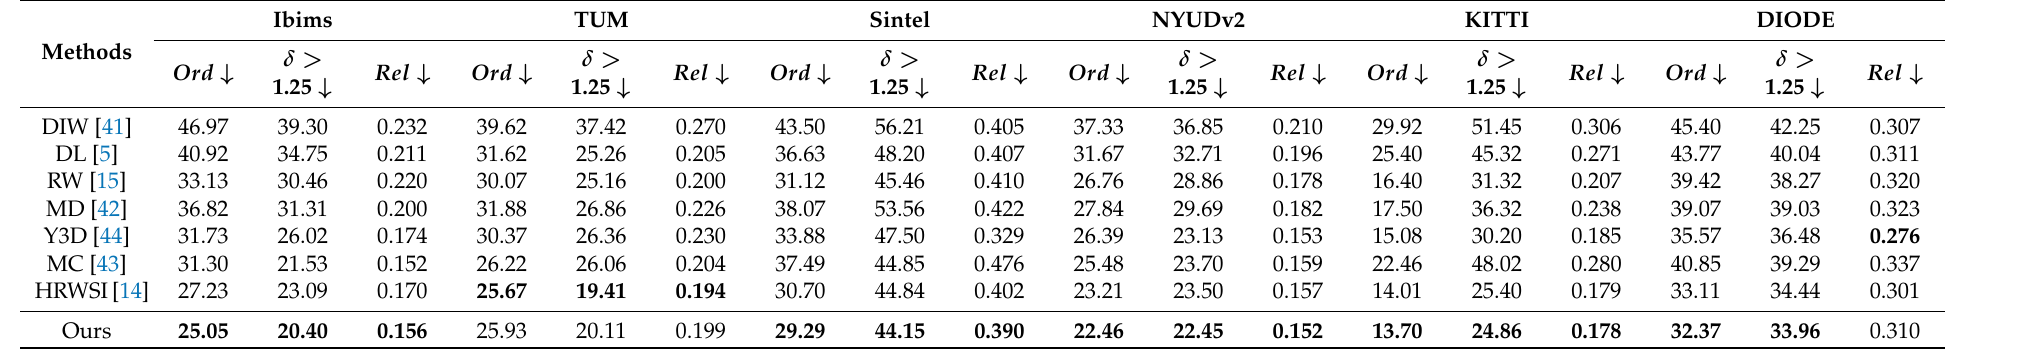
Table 4. Cross-dataset evaluation on six RGB-D datasets. The best performance is boldfaced.